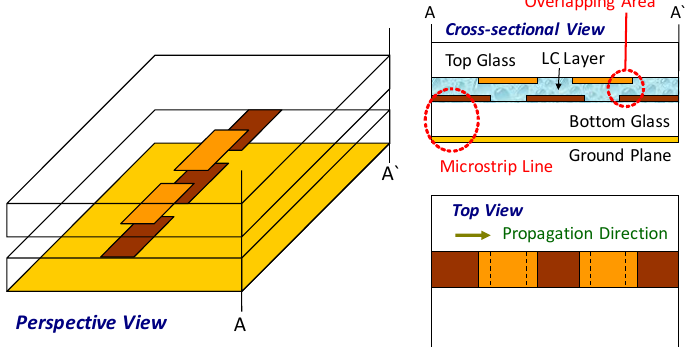
Figure 22. Schematic of a serially loaded microstrip delay line with LC varactors, build up by an overlapping area of an interrupted microstrip line filled with LC.